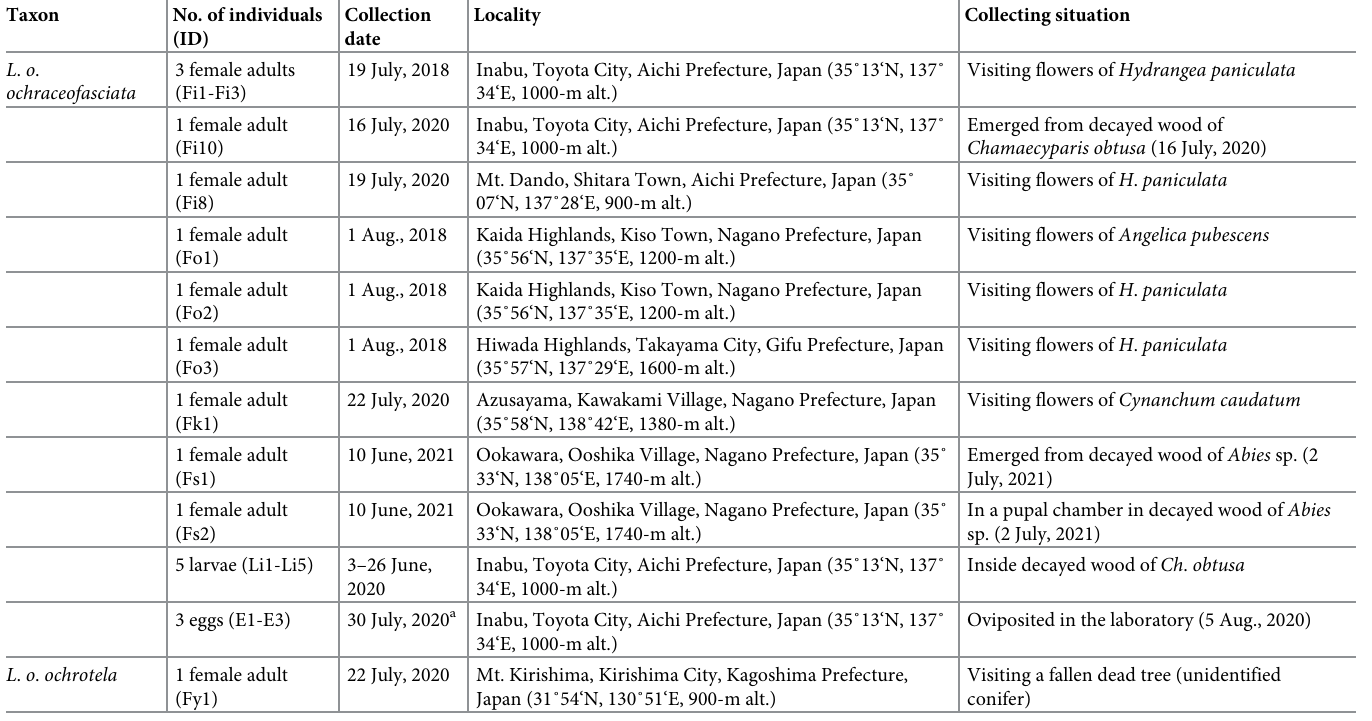
Table 1. Adults, larvae, and eggs of Leptura ochraceofasciata used for yeast